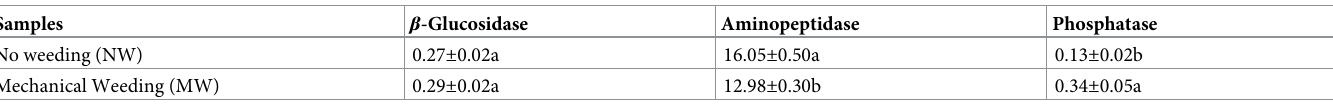
Table 1. Soil enzyme activities between NW and MW treatments in star anise plantations (n mol/g min -1 30˚C). Samples